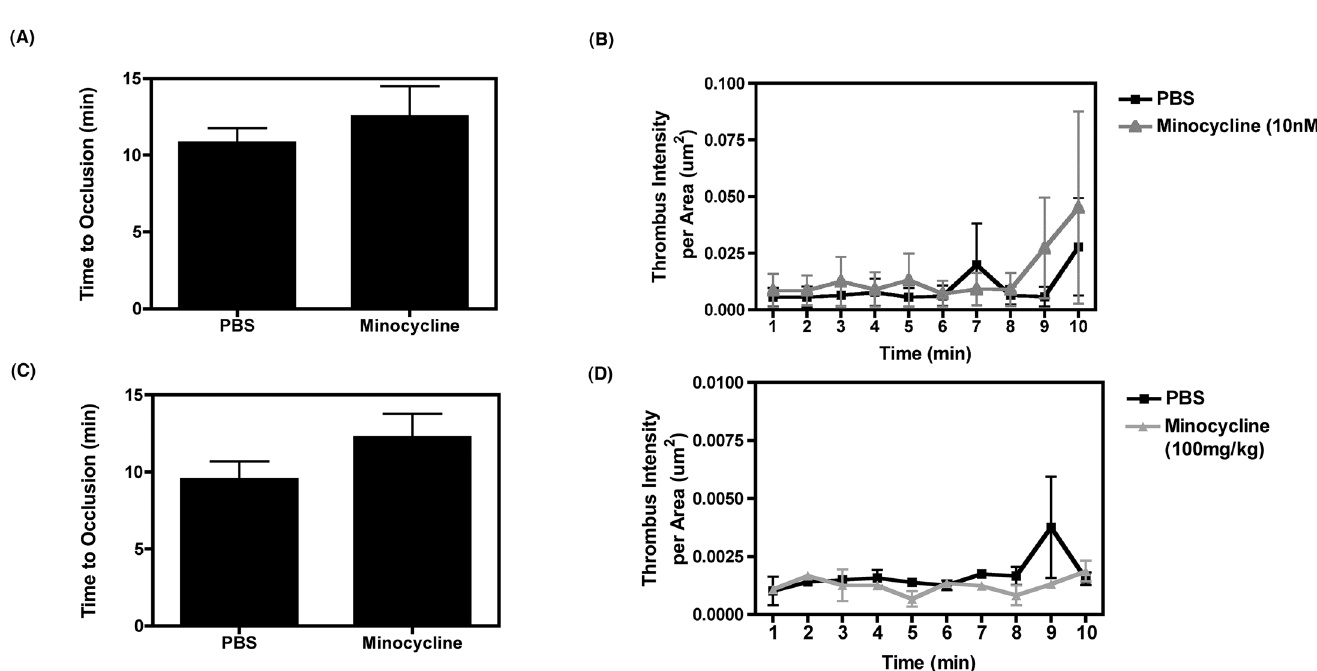
Fig 5. Minocycline does not affect thrombus formation. (A and B) Thrombus formation was measured in “ recipient ” mice (n = 6 for each group) that were injected with 10 μ m calcein green – fluorescently labeled platelets that were treated with either 1X PBS or minocycline. Vascular injury was induced by application of FeCl 3 to the mesenteric arteries for 45 s and subsequent thrombus formation was imaged and the following measurements were assessed over time: (A) the time to vessel occlusion, (B) thrombus intensity per area ( μ m 2 ) over time. (C and D) Thrombus formation was also assessed in mice treated with 2 injections of either PBS or 100mg/kg minocycline (n = 3 for each group, injections were 12 hr apart) by measuring (C) the time to vessel occlusion and (D) thrombus intensity per area ( μ m 2 ) over time. Data was compared using a student ’ s T test for (A) and (C) and a one way ANOVA test for (B) and (D) followed by Bonferroni ’ s test for multiple